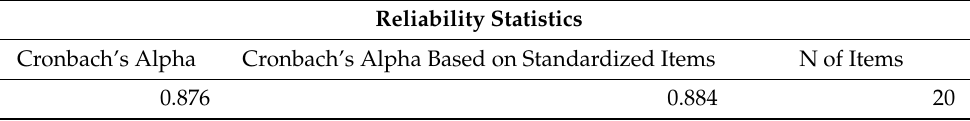
Table 6. Cronbach’s alpha co-efficient for worker component.